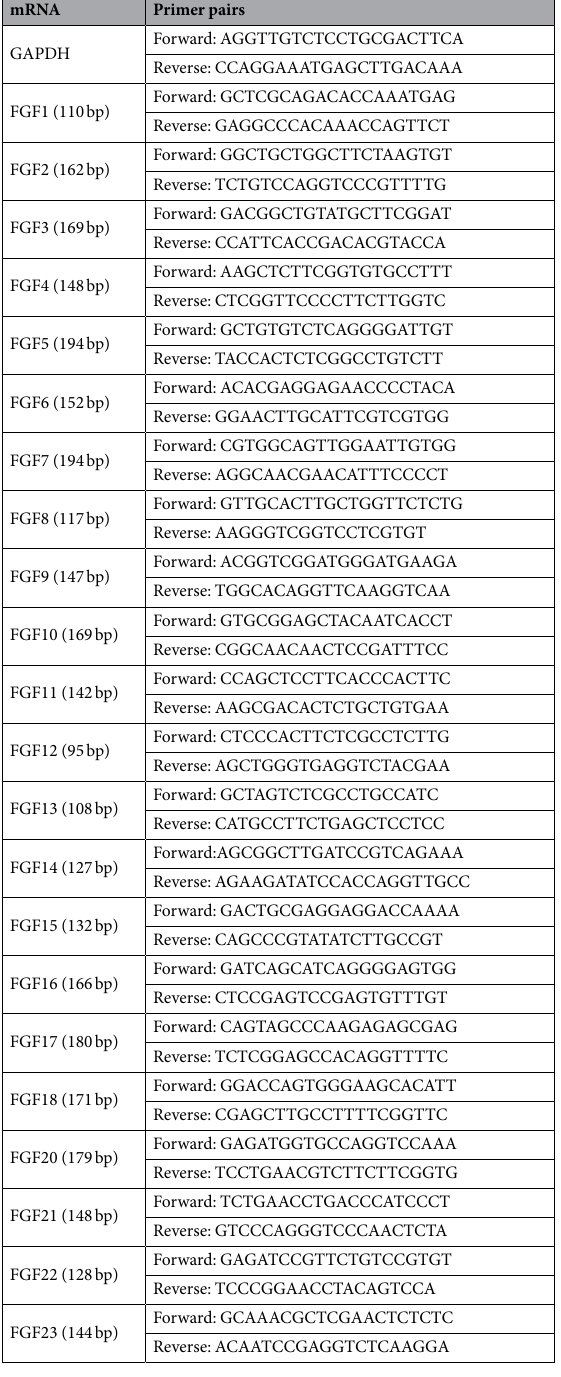
Table 1. Primer pairs of all FGFs in